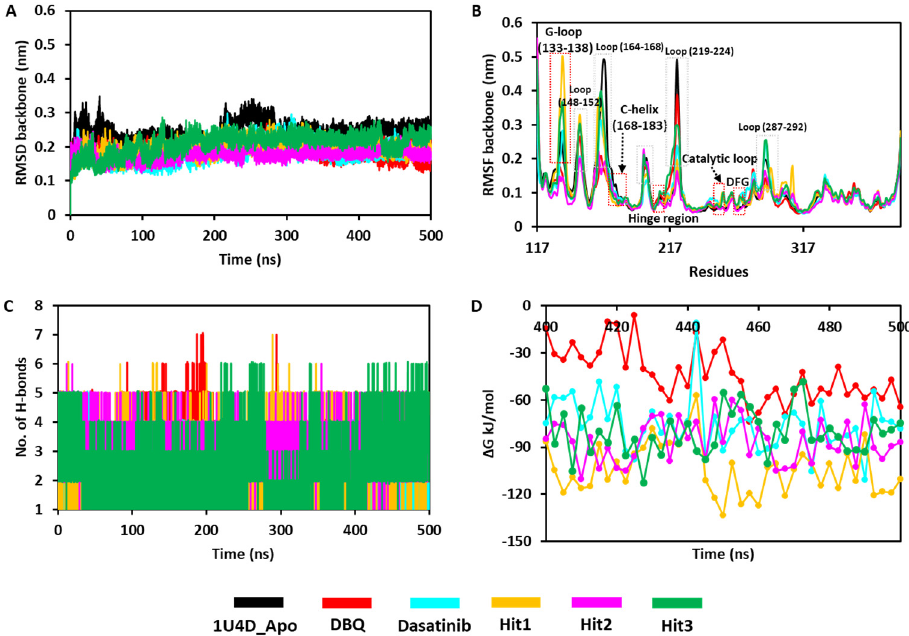
Figure 5. Molecular dynamic simulation analyses. ( A , B ) Backbone RMSD and RMSF. ( C ) Number of H-bonds and ( D ) binding free energy plots generated from MM-PBSA calculations.